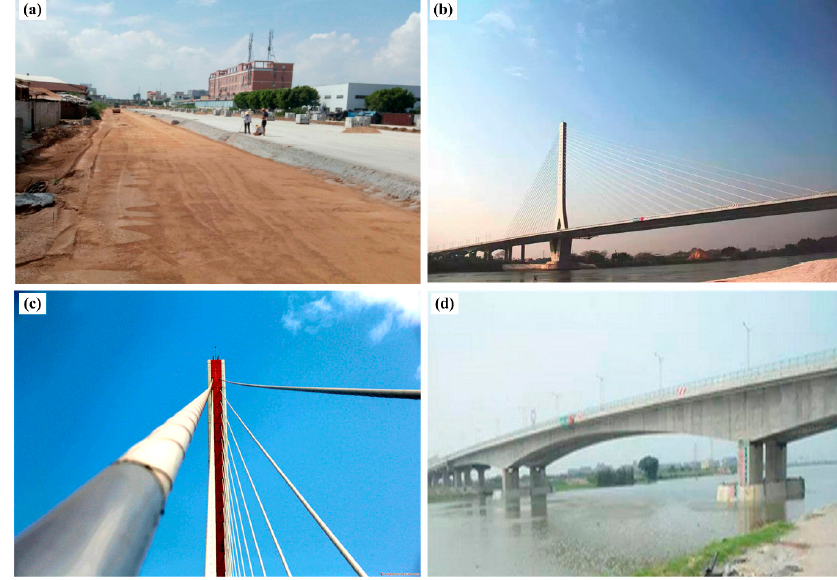
Figure 3 . Site pictures: ( a ) Soft clay subgrade along the test highway; ( b ) Rongguite bridge with central iron embankment tower; ( c ) Enlarge picture of the iron tower in ( b ); ( d ) Anlite Bridge.